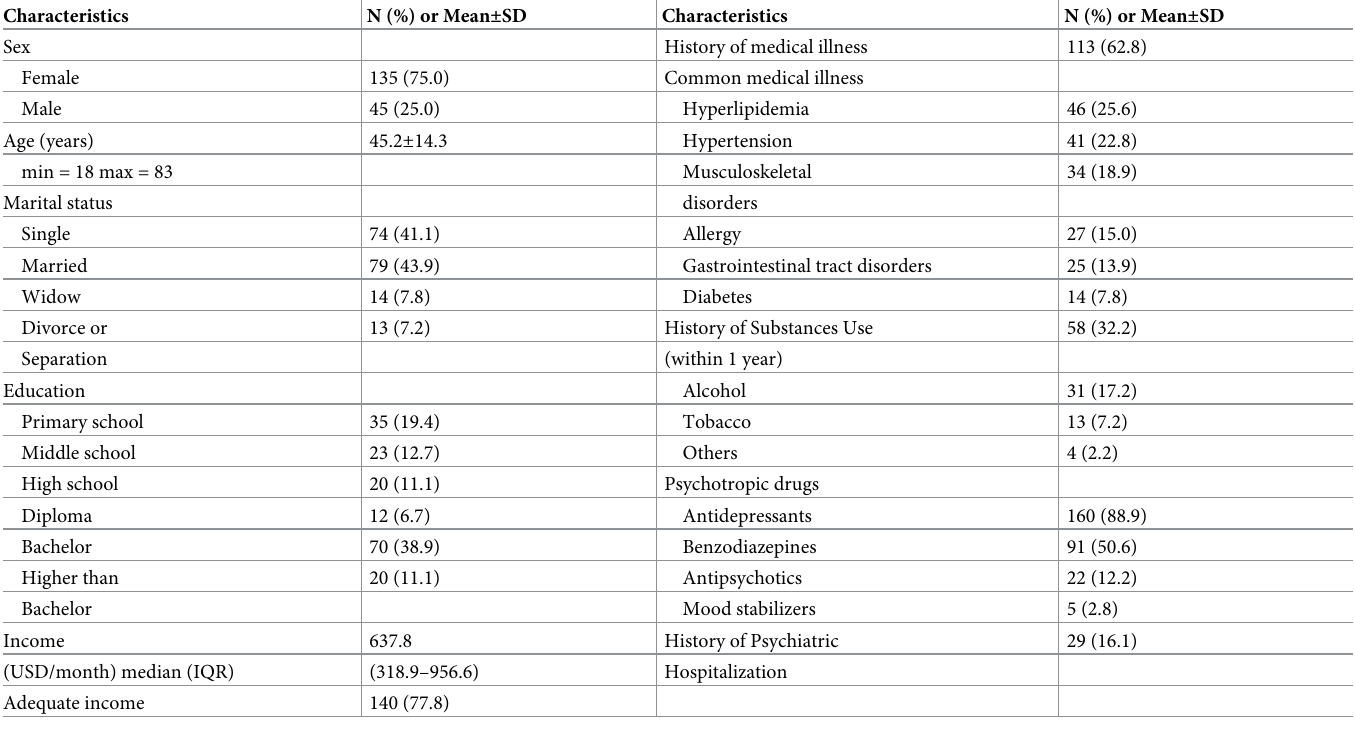
Table 1. Participant’s